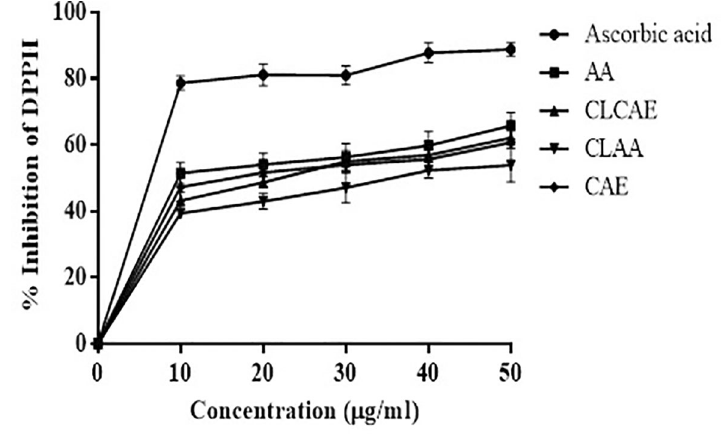
Figure 7. In vitro antioxidant study of CLCAE and CLAA (n=3).